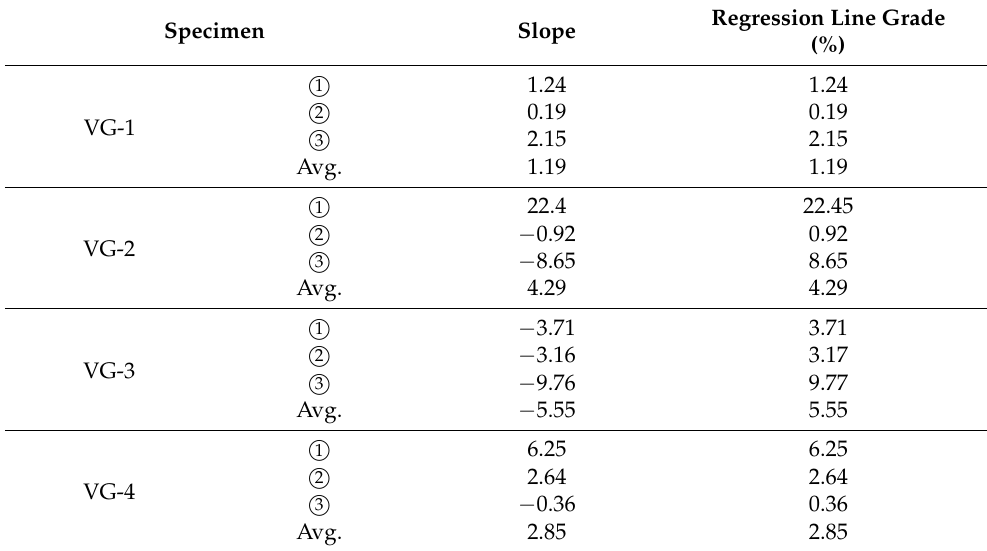
Table 10. The regression line grade calculation results.